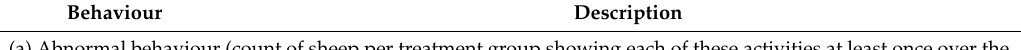
Table 1. Description of behaviour used to score sheep from 20 s video clips; (a) abnormal behaviour, (b) restlessness, and (c) percentage of time spent waling, grazing and